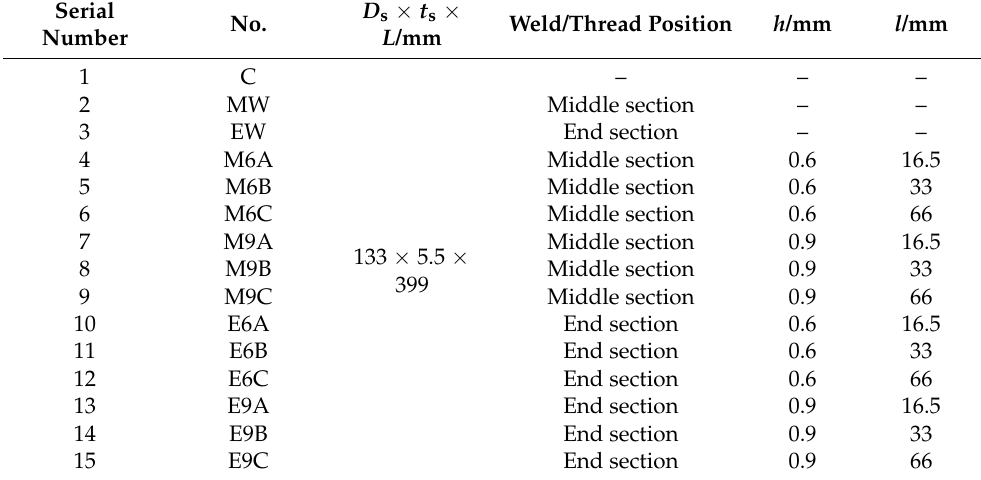
Table 1. Parameters of